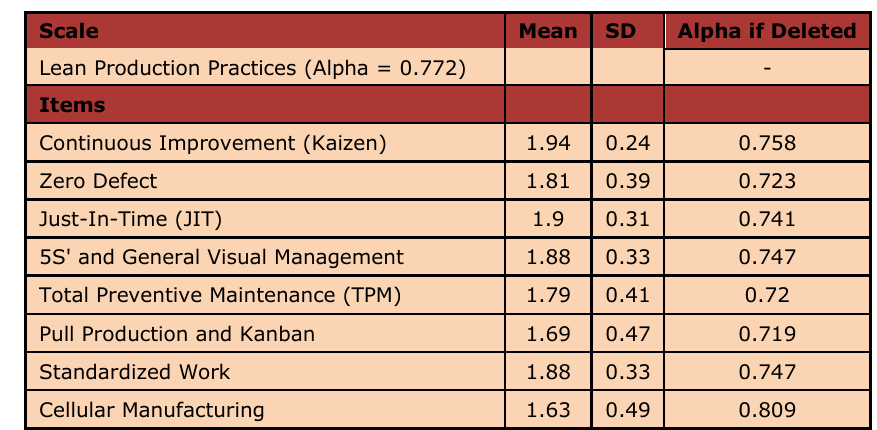
Table 2. Reliability analyses of Lean Production Practices